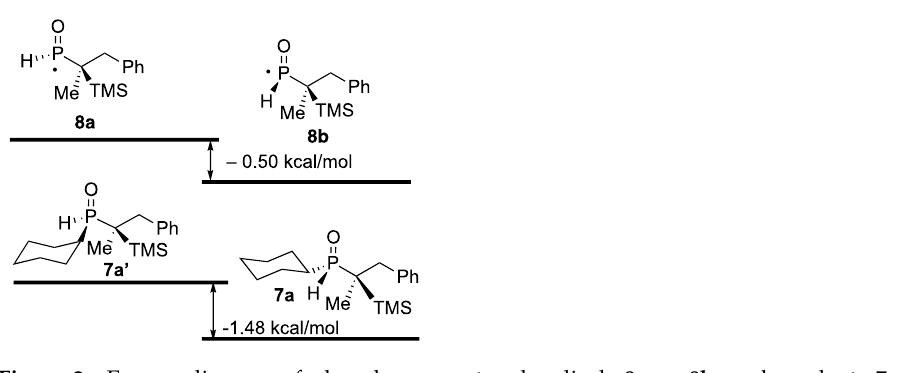
Figure 2. Energy diagram of phosphorus centered radicals 8a an 8b , and products 7a and its diastereomer 7a (cid:48) . Table 2. Radical addition of 5 to a range of alkenes.